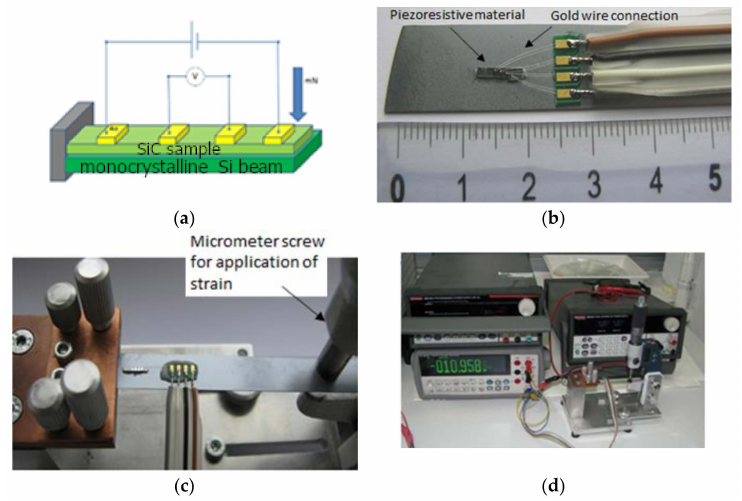
Figure 4. The testing stage used to analyze the piezoresistive effect of bulk crystals at room temper- ature. Schematic ( a ), connectors ( b ), mounting with micrometer screw ( c ) and general view of the testing stage ( d